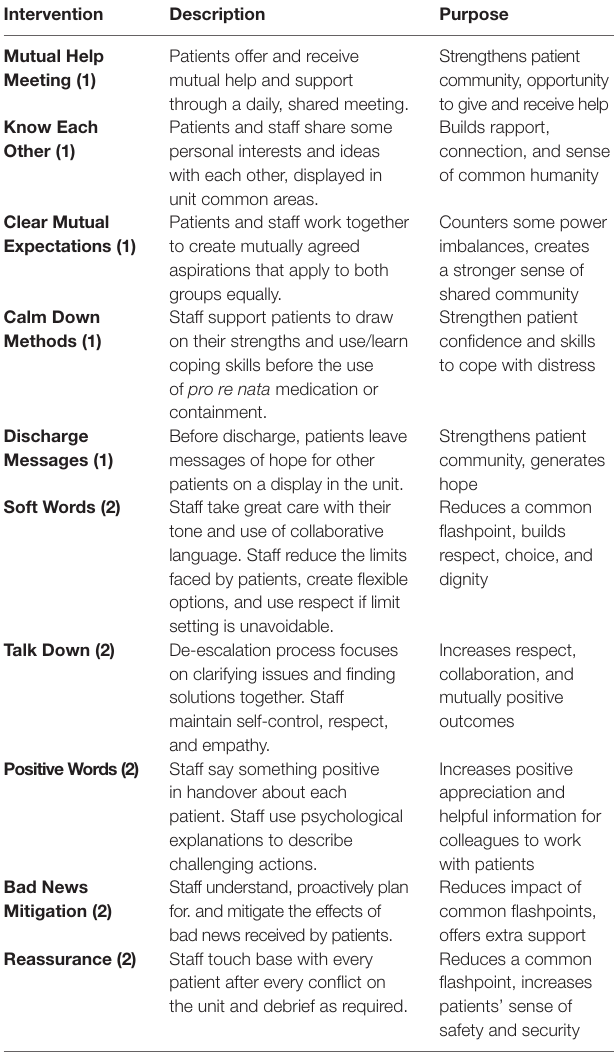
TABLE 1 | Safewards